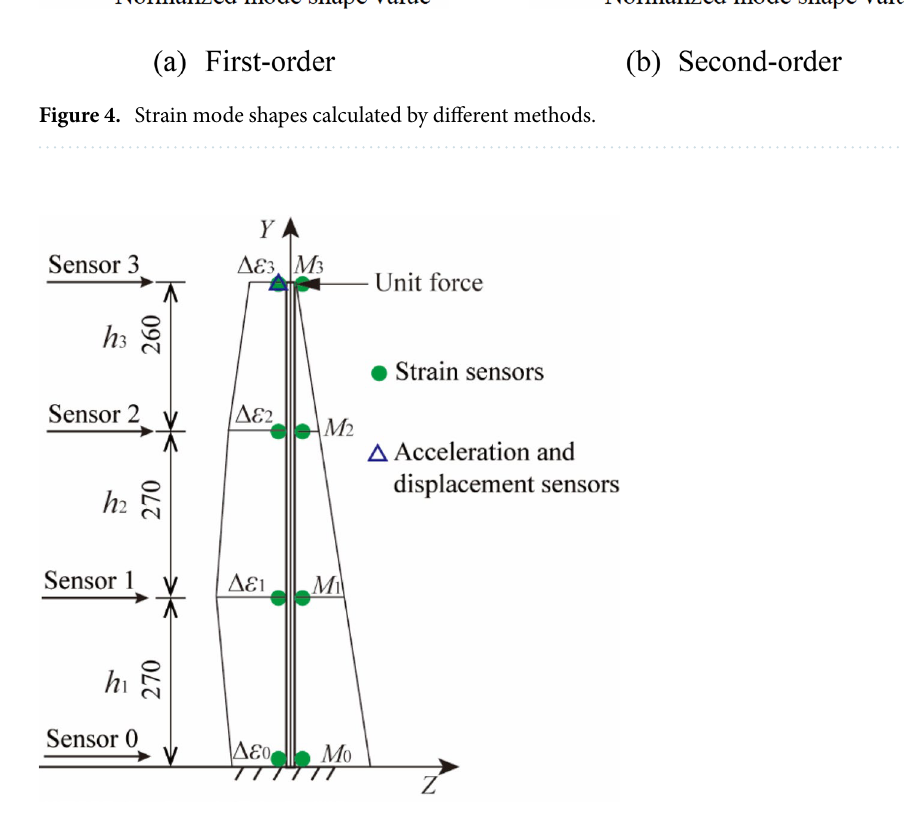
Figure 5. Schematic diagram of measurement points layout and parameters (unit: